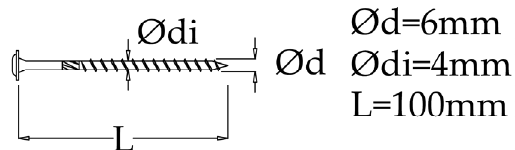
Figure 1. Flange-head partially threaded self-tapping screw used in this study.